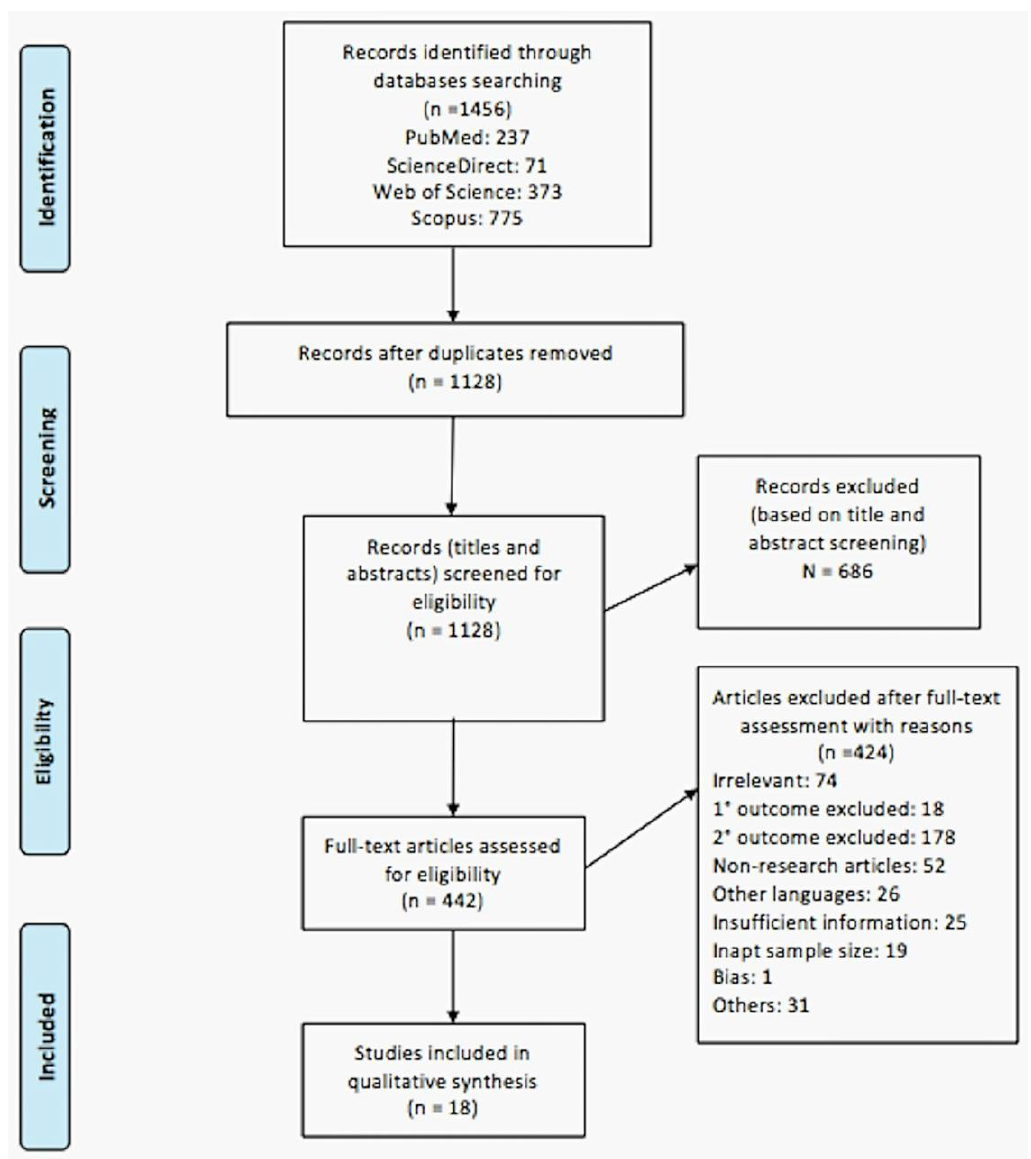
Figure 1. PRISMA flow diagram of study selection process.